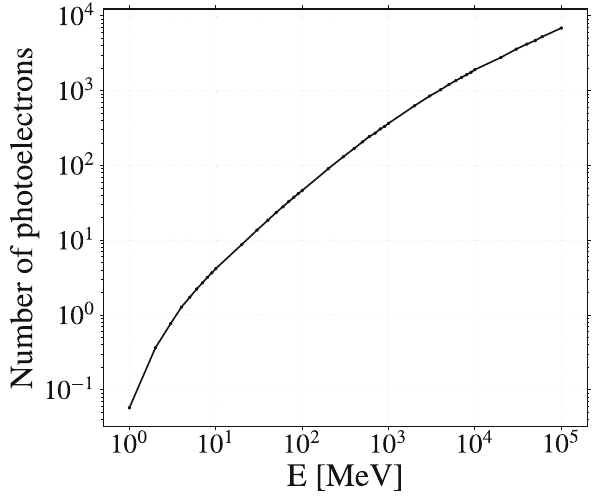
Fig. 2 Average gamma signal in the Mercedes station as a function of its energy. The gamma was injected vertically and uniformly at the top of the tank